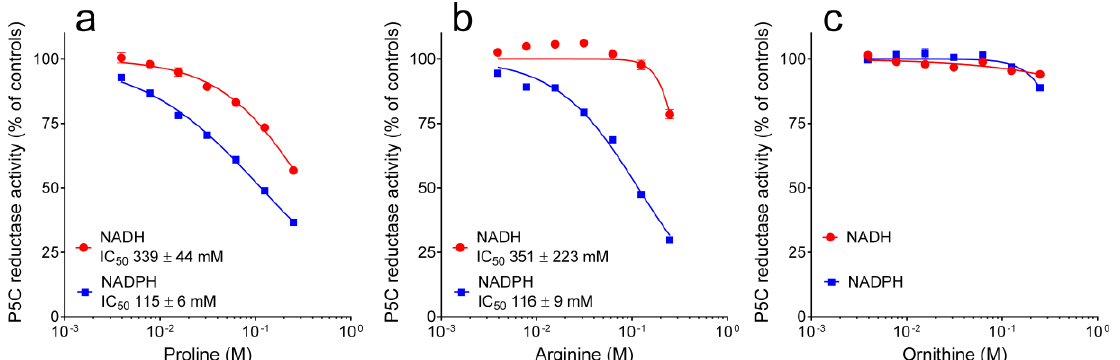
Figure 4. Effect of proline ( a ), arginine ( b ), and ornithine ( c ) on the activity of yeast P5C reductase. The purified enzyme was assayed in the absence or in the presence of increasing concentrations of a given amino acid, using either NADH or NADPH as the electron donor. Results were expressed as the percent of the activity obtained with untreated controls. For arginine and ornithine, added as hydrochlorides to prevent changes in the pH of the reaction mixture, controls received the same level of NaCl. Data are means ± SE over three replicates.